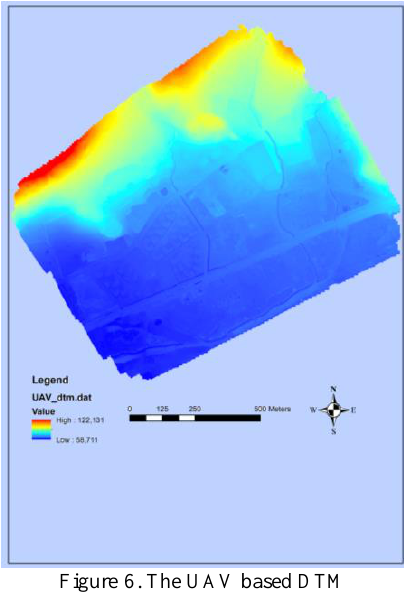
Figure 6. The UAV based